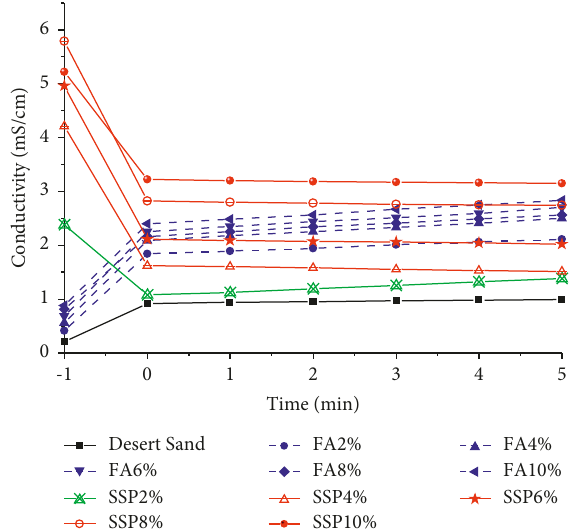
Figure 5: Changes in the conductivity of the bacteria in different mineral solutions for 5min.